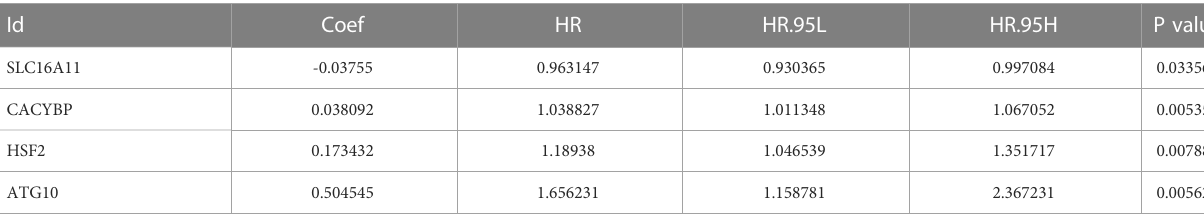
TABLE 4 Tex-related prognostic model by multivariate Cox regression. Id